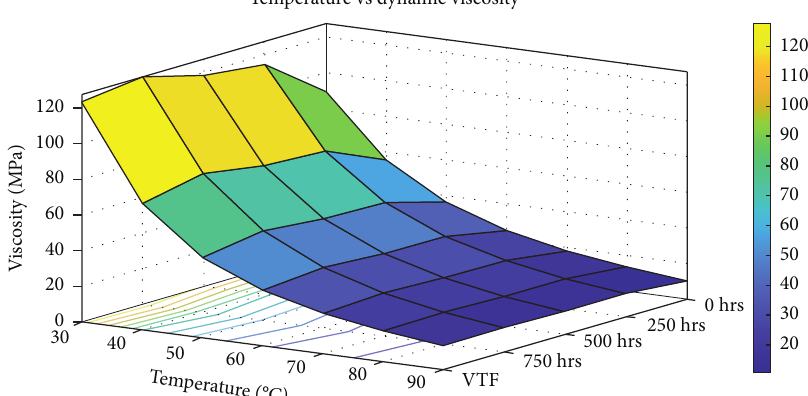
Figure 9: Change in dynamic viscosity with respect to temperature.